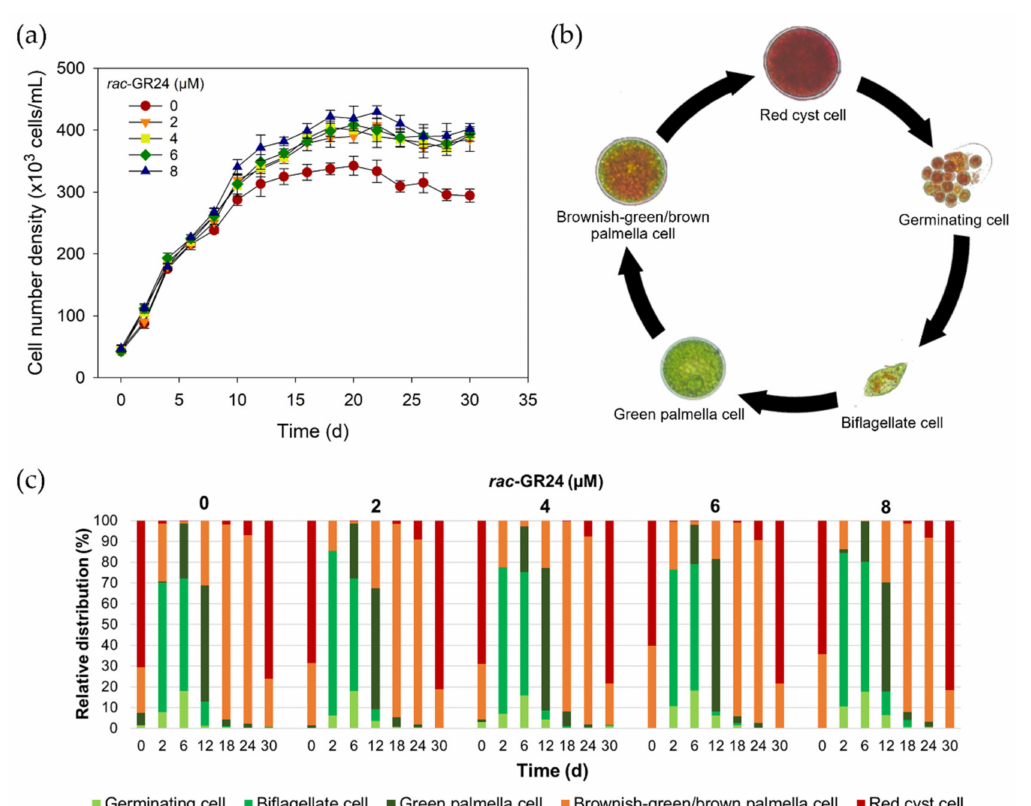
Figure 2. Time-course profiles of changes in the cell number density ( a ), optical shape ( b ), and relative morphological distribution of cell type ( c ) of Haematococcus pluvialis during 30 d photosyn- thetic cultivation under different rac -GR24 concentrations (2–8 µ M). H. pluvialis cells were classified into 5 distinct types (red cyst, germinating cell, biflagellate cell, green palmella, and brownish- green/brown palmella) and counted using an improved Neubauer counting chamber under an optical